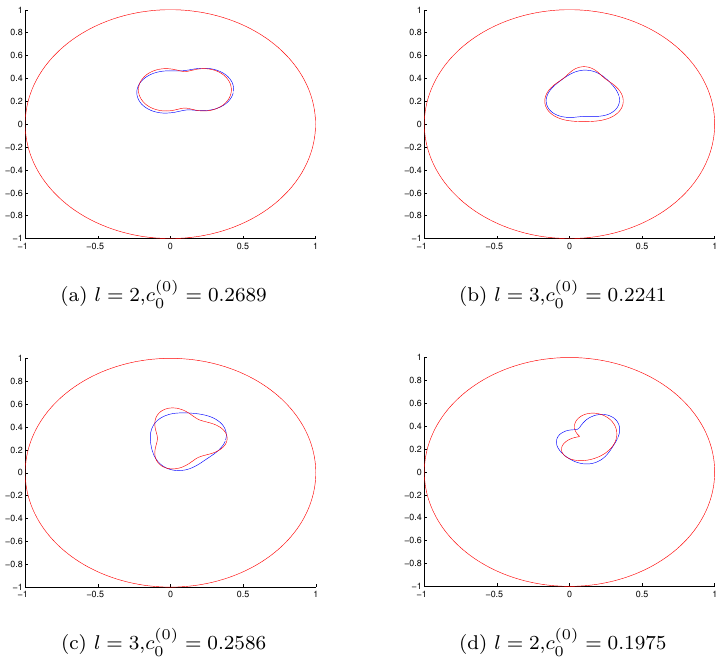
Figure 7. (a) Peanut; (b) peach; (c) pear; (d) bean. Apply LMA to reconstruct the shape of the coefficient with 1% noise data along with exact solution (red) and recovered solution (blue), respectively for Example